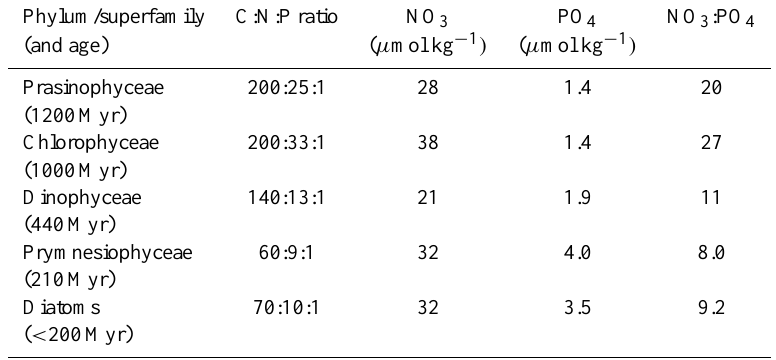
Table 3. Expected ocean composition if dominated by various phyla of phytoplankton. Predicted from the Redfield ratios found by (Quigg et al., 2003) and the adapted LW model, assuming the N:P Redfield ratio is the threshold below which N 2 -fixation occurs.